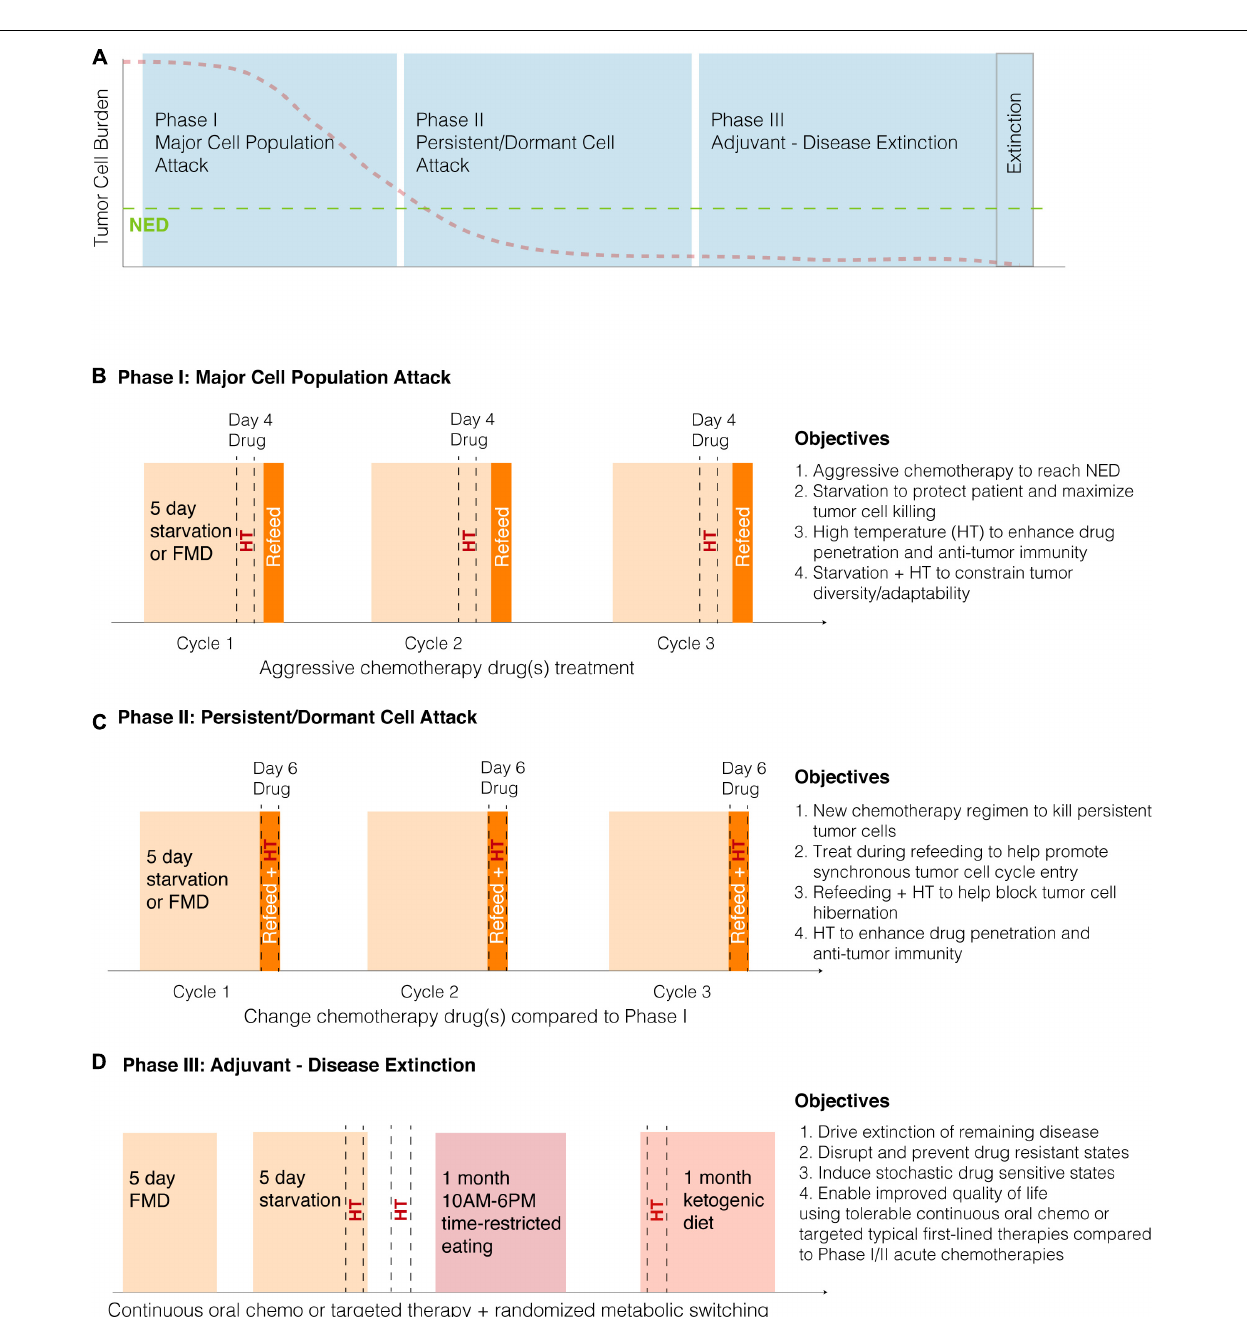
FIGURE 9 | A three-phase paradigm for combining starvation/FMD/diet with hyperthermia and drug treatments to promote metastatic disease extinction. (A) The schematic depicts two phases of combinatorial treatment to eliminate the disease. In Phase I, the goal is to rapidly drive the disease to NED using combinations of drug treatments, starvation and hyperthermia. In Phase II, the goal is to activate, sensitive and kill persistent and dormant tumor cells in the body that will lead to the recurrence of the disease in the future. In Phase III, the goal is to drive the disease to extinction by combining a continuous drug treatment that enables a high quality of life with randomized starvation, intermittent fasting, dietary and hyperthermic interventions that cause unpredictable and different metabolic states to eliminate remaining disease and prevent recurrence. (B) In Phase I, by delivering drug treatment strikes during starvation periods (day 4 of starvation or FMD), tumor cells are sensitized to treatment and healthy cells are protected, improving drug efficacy and protecting patient health and quality of life. By including hyperthermia (HT) during drug treatment strikes, drug penetration into tumor sites may increase, hypometabolic states may be blocked and tumor cell diversity and adaptability are expected to be impaired. (C) In Phase II, the drug strikes and HT are applied during the re-feeding period after a starvation/FMD cycle, where the goal is to flush out persistent hypometabolic cancer cells and drive them into cell division, homogenize them and kill them with treatment. (D) In Phase III, continuous oral chemo or targeted therapies are used in combination with randomized and unpredictable metabolic switches to disrupt the epigenetic and gene expression cancer cell landscapes to break emerging drug resistant phenotypes and stochastically induce drug sensitive states over time, ultimately leading to complete disease extinction.